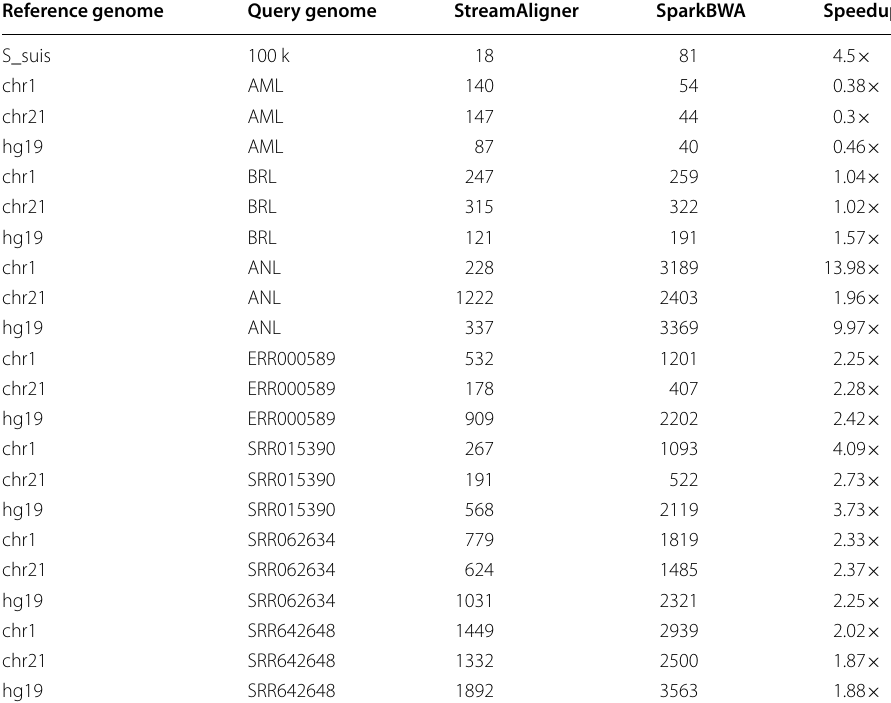
Table 2 StreamAligner performance (times reported in seconds)